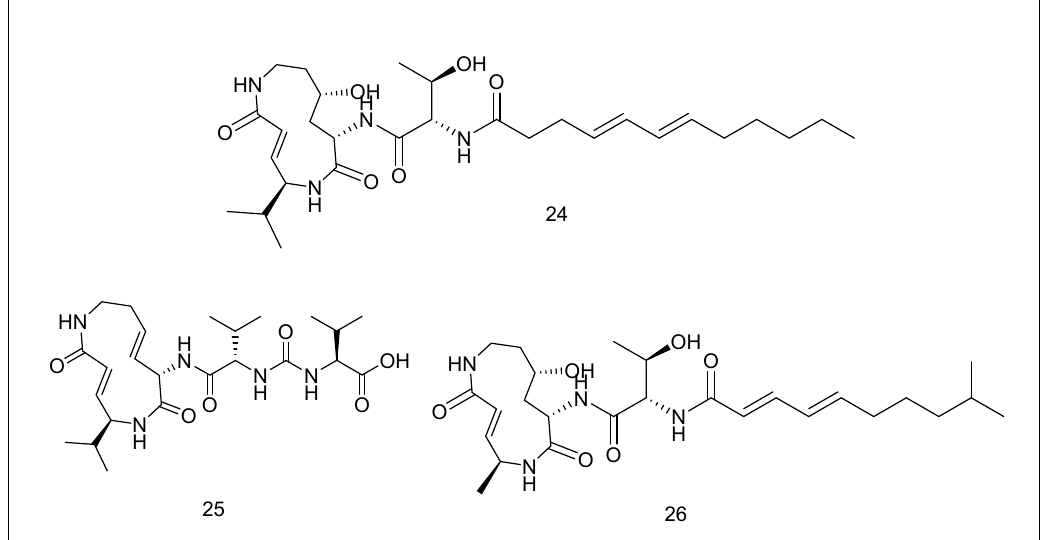
Figure 10. Chemical structures of the glidobactin ( 24 ), syringolin A ( 25 ), and cepafungin I ( 26 ). In terms of syrbactins’ modes of action, syringolin A has been found to irretrievably restrict all three key catalytic domains in the eukaryotic 20S proteasome, though suppression of the β 2 subunit is minor, because this component has a Ki’ of 843 nM against the fi ve subunits and a Ki’ of 6.7 µM against the β 1 subunit. The β 5 subunit is the most sensitive [172,173]. The Ki’ di ff erentiates from the IC 50 in that it provides more information about the concentration required to interact with 50% of the targeted protein, irrespective of inhibiting capacity [174]. Glidobactin A, on the other hand, cannot inhibit the β 2 subunit of the proteasome but may irreversibly inhibit the β 5 subunit (Ki’ of 49 nM, the greatest antagonist of this site amongst syrbactins), and to a lesser extent, the β 2 (Ki’ of 2 µM) [172]. Syrbactins cause apoptosis and autophagy in neuroblastoma cells, resulting in cell death. p53 and Akt/PKB are triggered simultaneously, which fi ts the pro fi le of an appropriate proteasome antagonist for cancer treatment [171]. Apoptosis-inducing action of these compounds has been found in neuroblastoma cells (SK-N-SH and LAN-1) and in SKOV3 (ovarian cancer) cells [175–177]. 2.3.5. Tyropeptins Tyropeptins A ( 27 ) and B ( 28 ) (Figure 11) were fi rst extracted from the soil actinobacteria Kitasatospora sp. [178,179]. Tyropeptin A inhibits the proteasome most e ff ectively. It has a substantial inhibitory e ff ect against the proteasome’s proteolytic binding domains, such as chymotrypsin (IC 50 of roughly 20 nM) and trypsin (IC 50 of 2.93 µM), despite being inept at blocking the action, like caspase of the proteasome in vitro [178]. Tyropeptin A inhibits proteasomal action and is identical to entire cells [180]. The IC 50 of these compounds for inhibiting the site like chymotrypsin of 20S proteasome is as minimal as 1.4 nM [181].